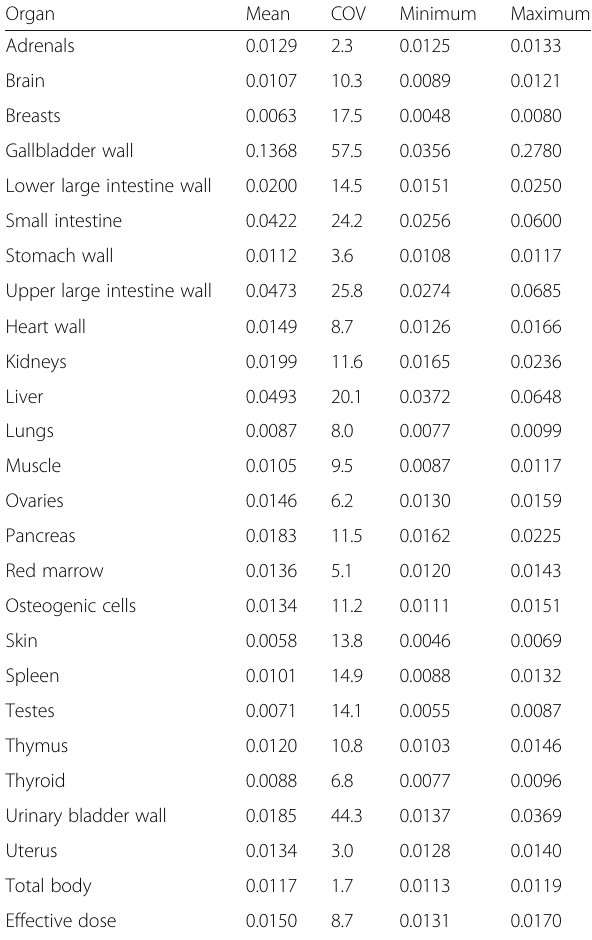
Table 4 Absorbed organ dose (mGy/MBq) and effective dose (mSv/MBq) using ICRP 30 gastrointestinal